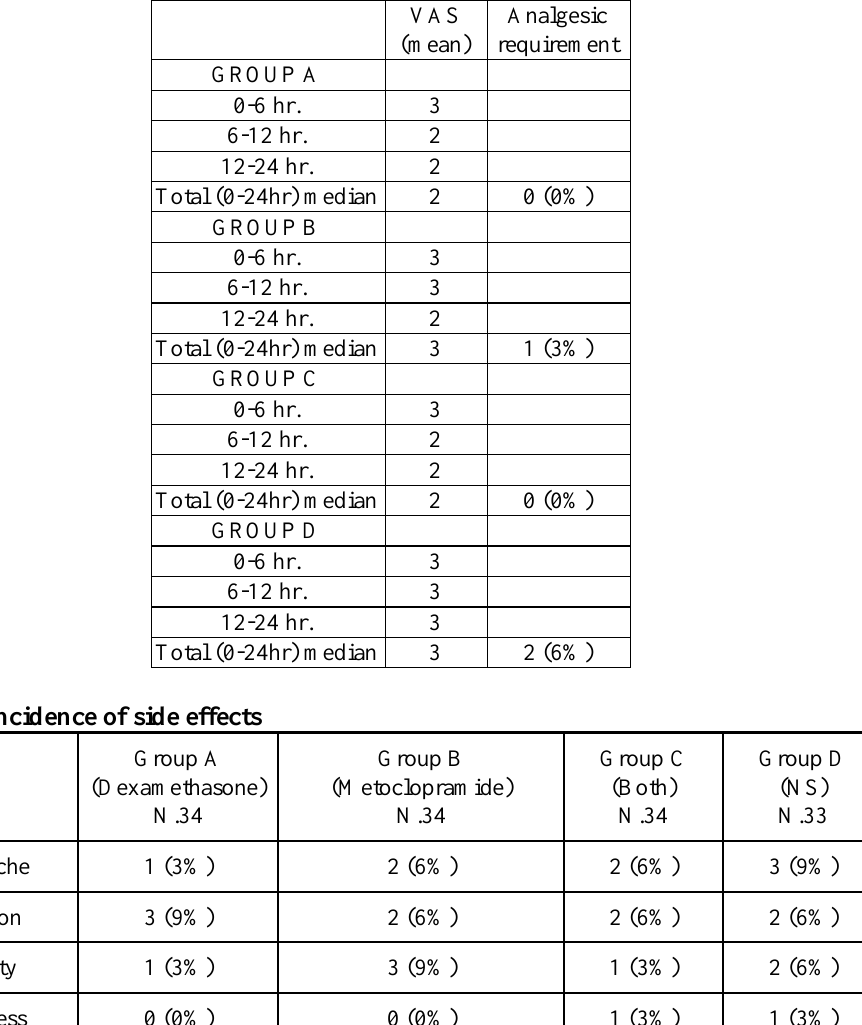
Table 3: Postoperative visual analog scale (VAS) pain score